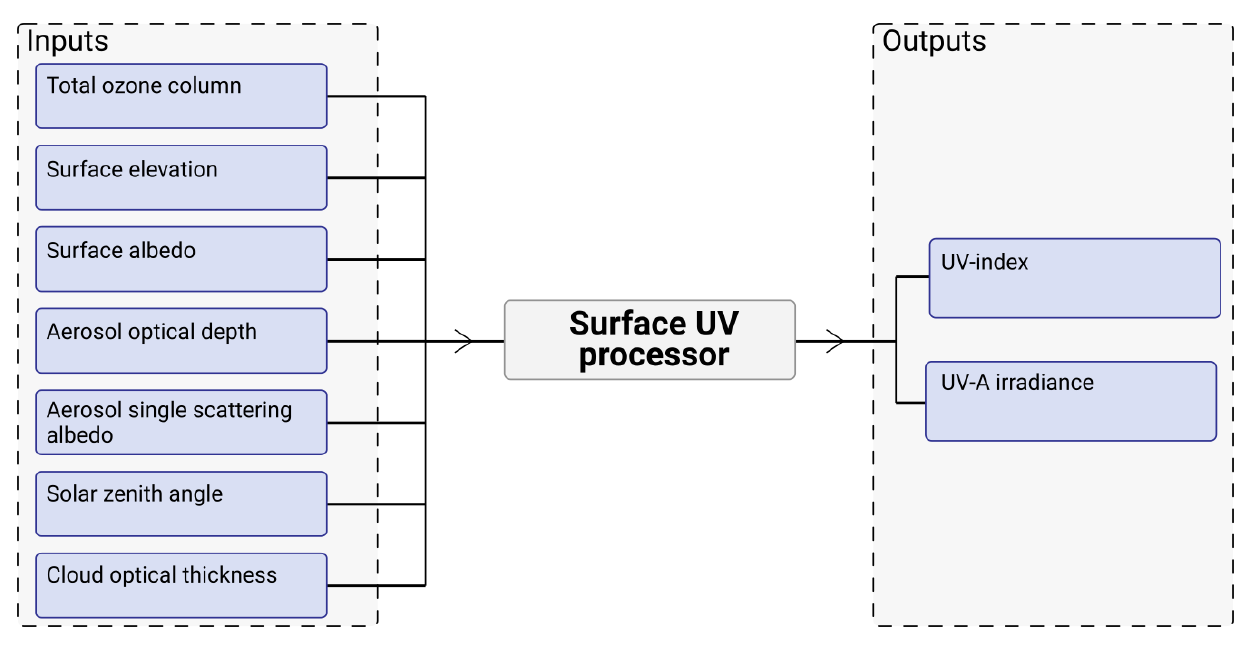
Figure 10. Schematic figure of the inputs and outputs of the surface UV